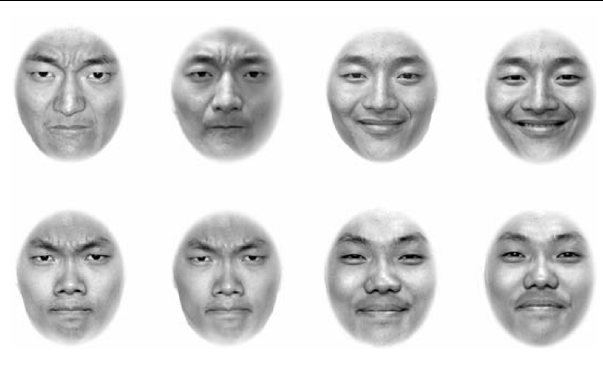
FIGURE 3 | Eight face photos used in Experiment 3. The top row of the four photos comes from Model A, and the bottom row of the four photos comes from Model E. In both the top and bottom rows, the first two photos show angry expressions, with a small difference in emotional intensity between them, and the last two photos show happy expressions, also with a small difference in emotional intensity between them.The discriminabilities of expression and identity were both low, with RT of 530 ms and 550 ms.